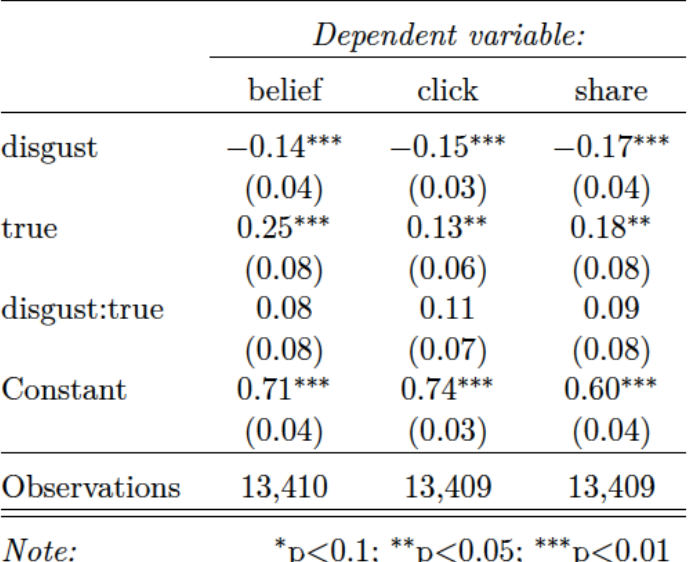
Table B7. Association between disgust and belief, click, and